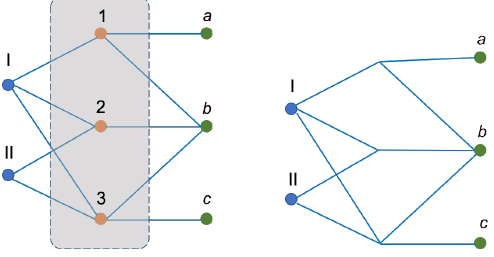
Fig. 5 Build the user-topic bipartite by removing the tweet nodes of the tripartite graph and leveraging the tweet nodes as the connection for user and topic